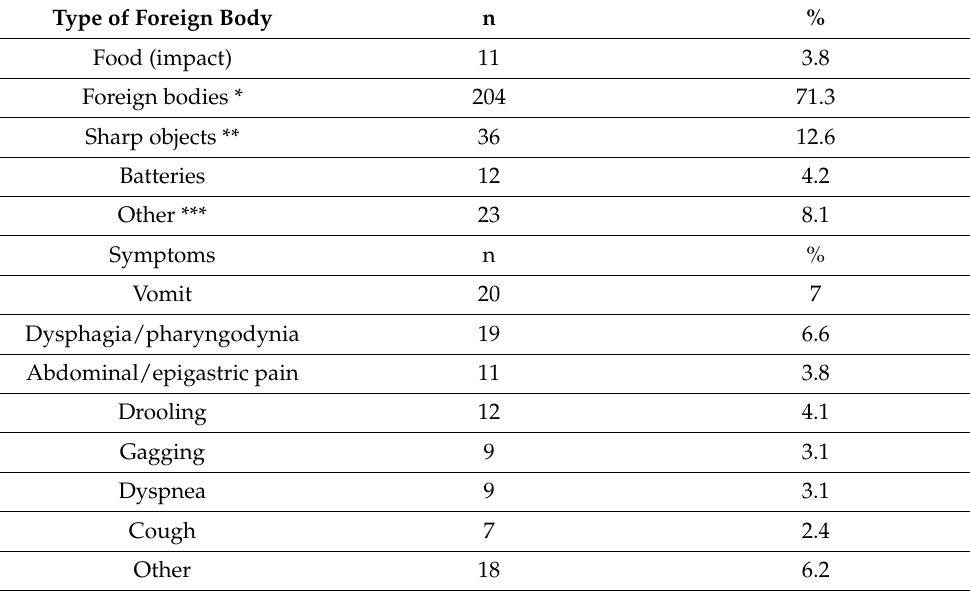
Table 1. Foreign bodies and